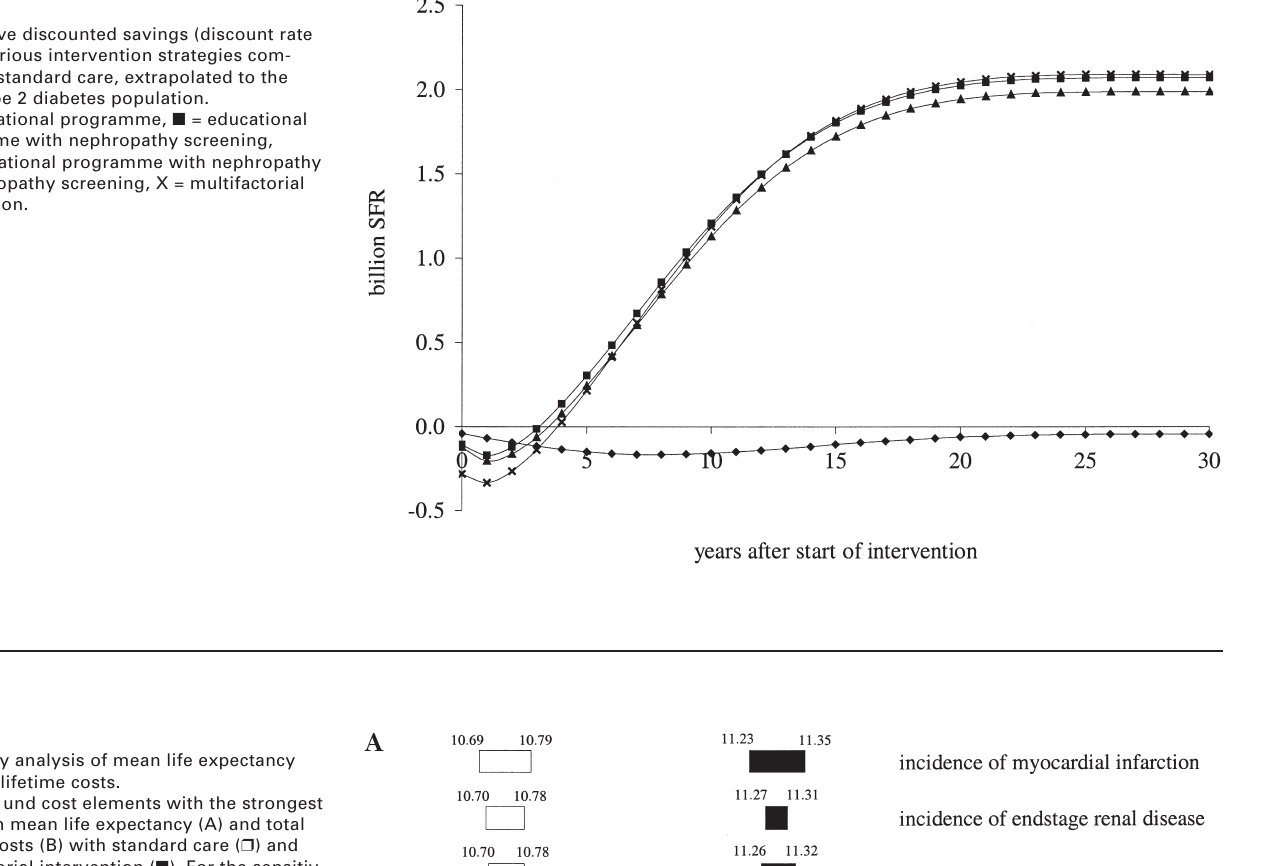
Sensitivity analysis of mean life expectancy and total lifetime costs. Variables und cost elements with the strongest impact on mean life expectancy (A) and total lifetime costs (B) with standard care ( ❒ ) and multifactorial intervention ( (cid:3) ). For the sensitiv- ity analysis all variables/cost elements were varied by + 10%. The sensitivity analysis is per- formed on values discounted at a discount rate of 3%. * Costs of diabetes treatment